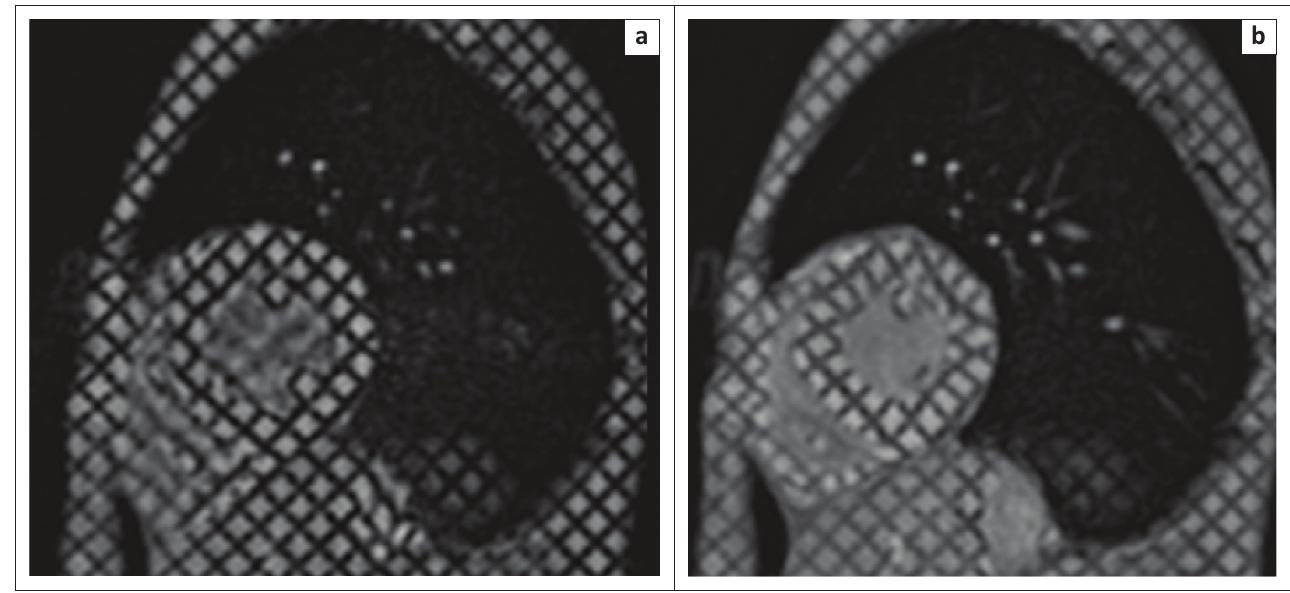
FIGURE 1: Short-axis images through the mid-left ventricle with application of myocardial tagging at end-diastole (a). Tag lines follow myocardial deformation (b) during the cardiac cycle and allow quantification of myocardial strain parameters in the circumferential, longitudinal and radial